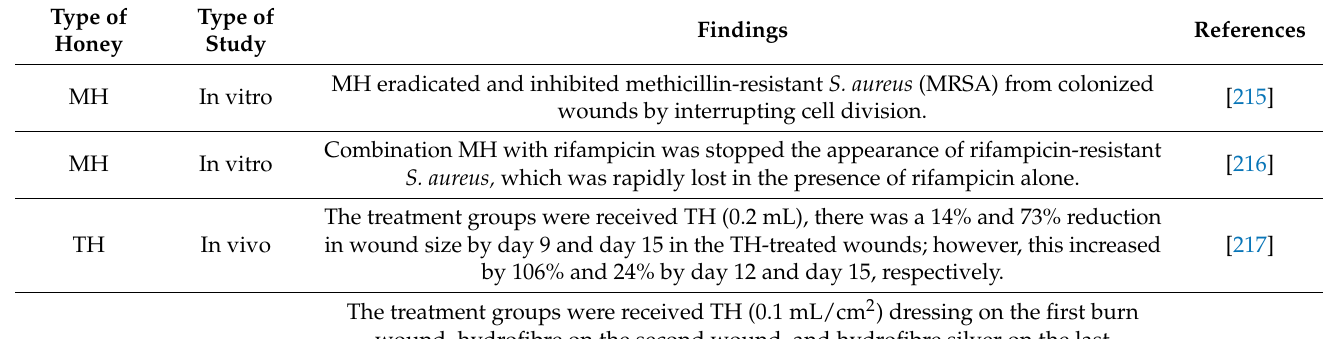
Table 6. Summary of wound-healing properties of MH, TH, KH, and